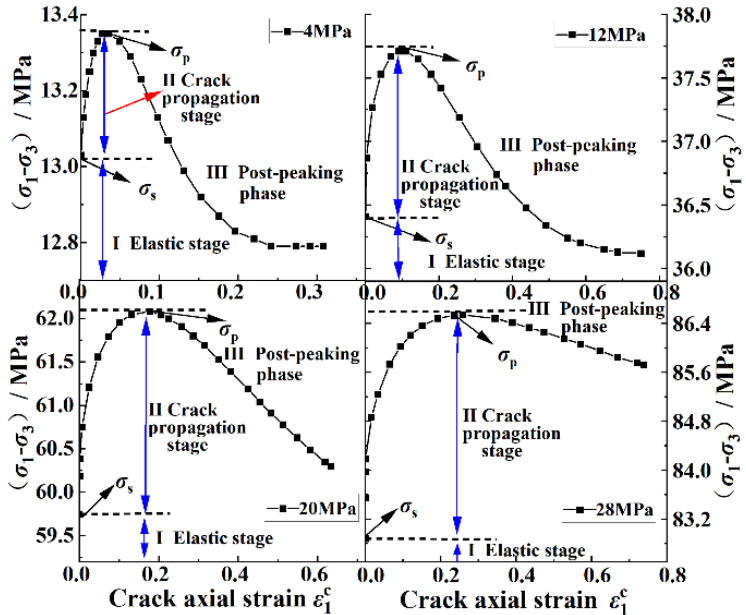
Figure 11. Axial stress–strain curves of cracks under different confining pressures.